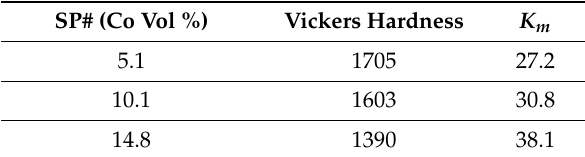
Table 1. Data from Exner et al. [10] on Co Vol %; Vickers hardness and toughness.